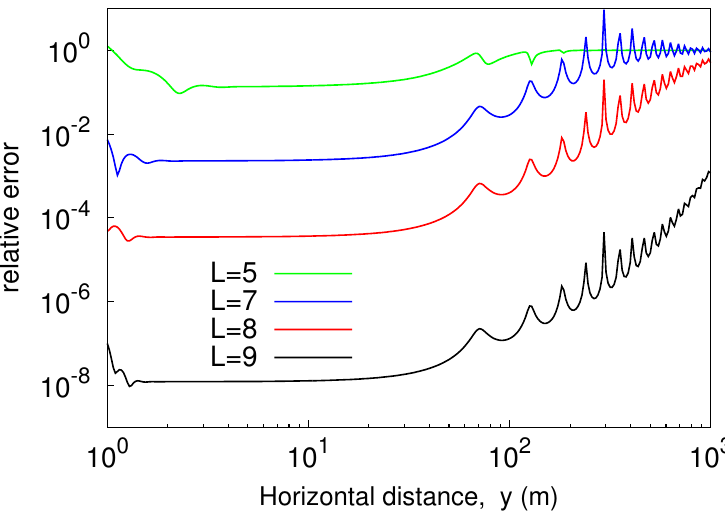
Figure 4. Relative error of (23) as compared to G7-K15 scheme, plotted versus y